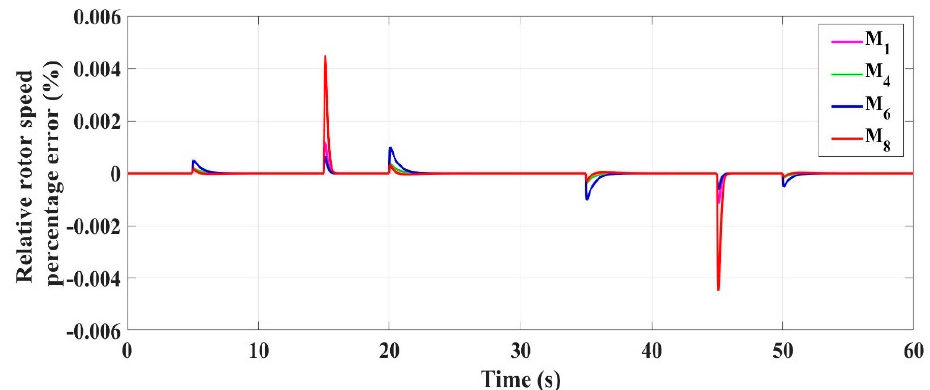
Figure 3. Relative rotor speed percentage errors (%).